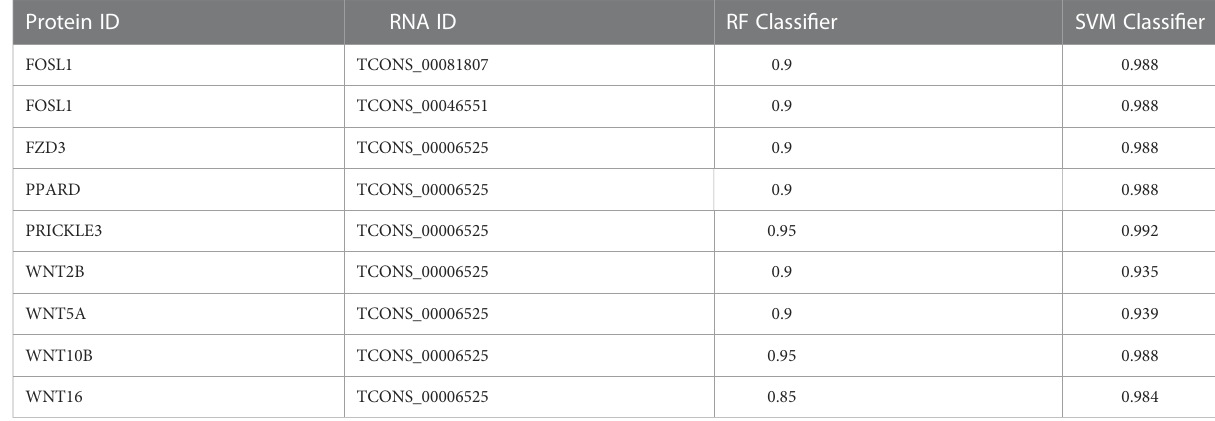
TABLE 2 lncRNAs and proteins binding information.